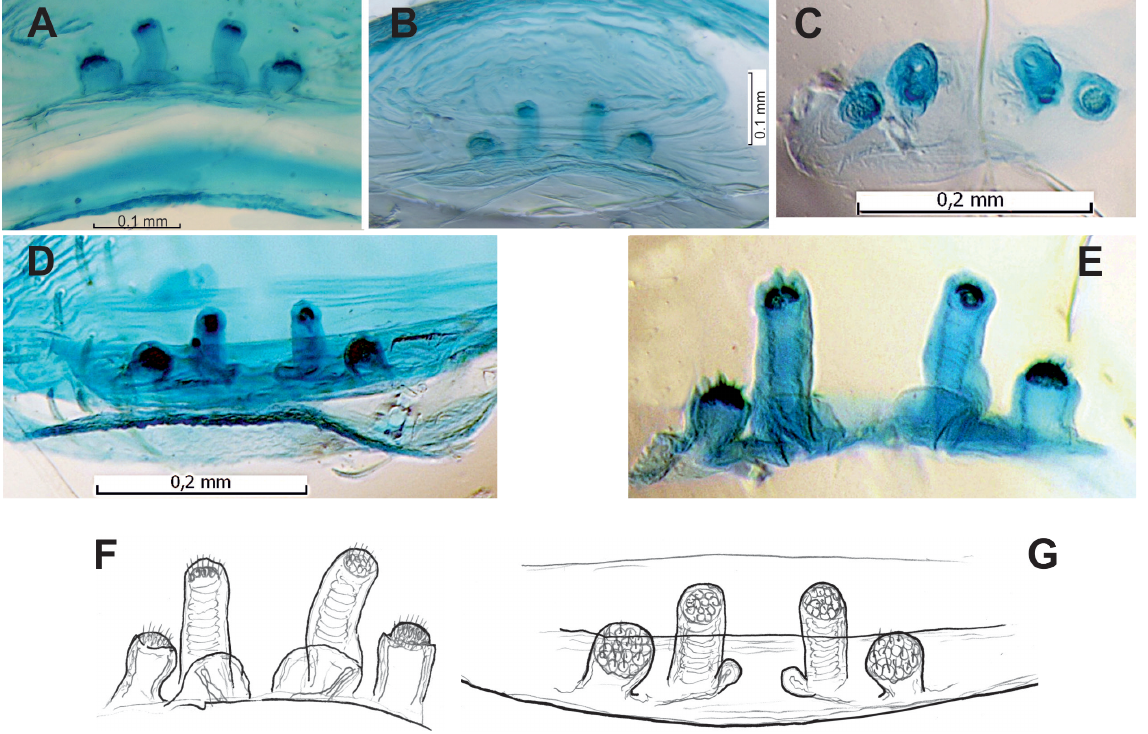
Fig. 21. endogyne of Zaitunia logunovi sp. nov., paratype, ♀. A–B , E–F . endogyne, dorsal. C . recep- tacles, posterior. D , G . endogyne, dorsal-anterior. Scale bars: a–B = 0.1 mm; C–D = 0.2